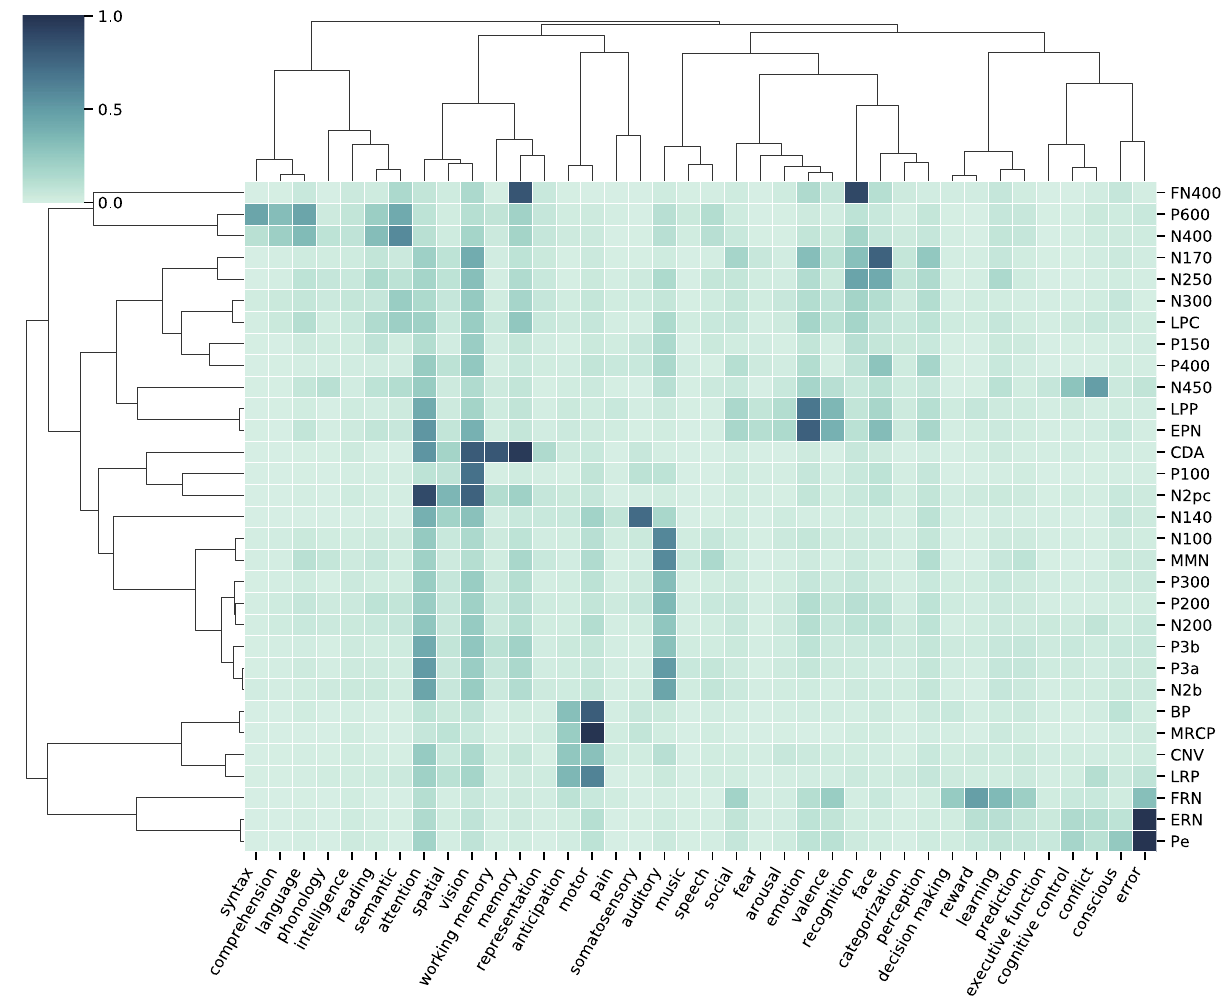
Figure 5. Cognitive-related associations. The heatmap is the normalized co-occurrence data, reflecting the percentage of articles for a given ERP that mention a particular cognitive term. Rows and columns have been re-ordered based on the similarity between ERPs and cognitive terms respectively. Dendrograms are hierarchical clustering based on cosine similarity. Note that only ERP components with at least 150 articles are included in this analysis. Figure created with the lisc Python package, version 0.2.0 (https:// lisc- tools. github.